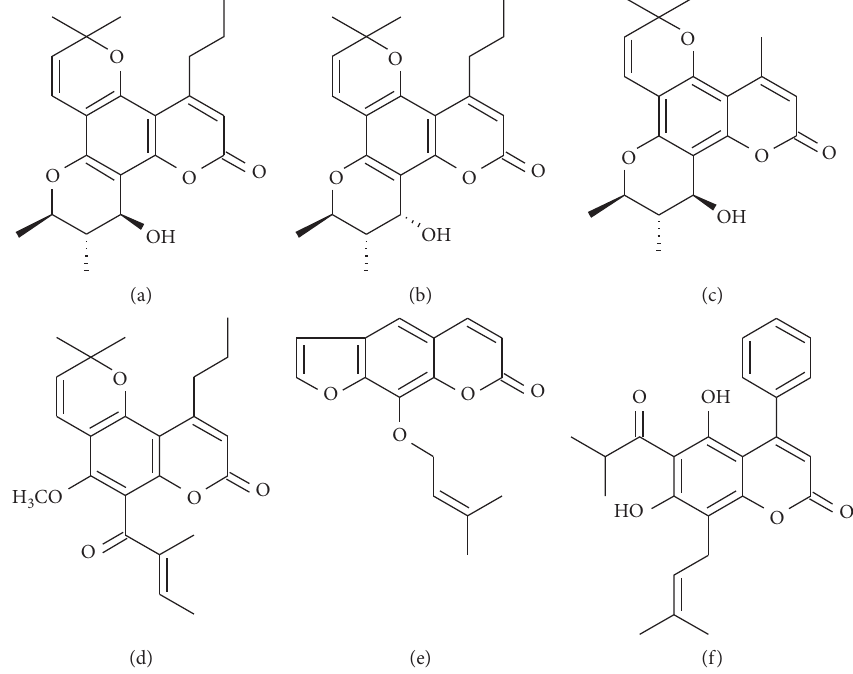
Figure 3: Chemical structure of representative coumarins with antiviral activity against HIV-1. (a) (+)-Calanolide A. (b) ( − )-Calanolide B. (c) Cordatolide A. (d) GUT-70. (e) Imperatorin. (f)